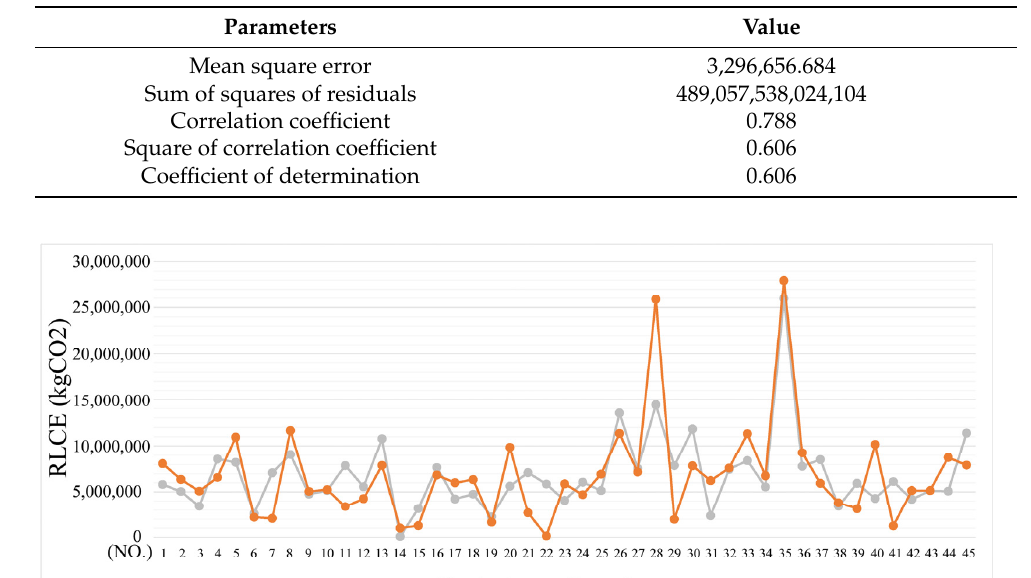
Figure 5. Grey correlation coefficient between BEF and RLCE. Table 3. Relevant parameters of optimal function relation equation.